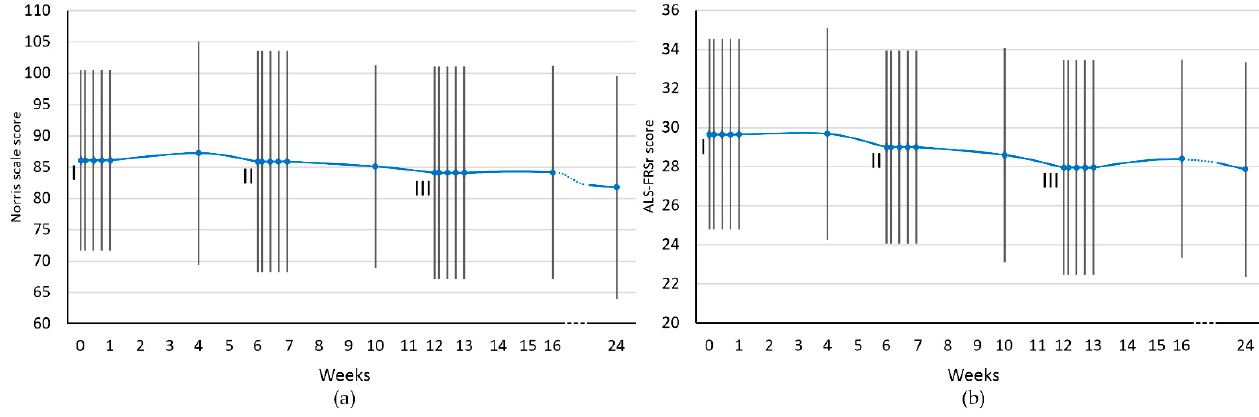
Figure 1. Functional scales assessment scores for the whole study group. ( a ) Norris scale; ( b ) ALS-FRSr scale. I, II, III—cell administration procedure. The results are presented as the mean values. Blue dots represent the analyzed timepoints. Vertical lines represent SD.